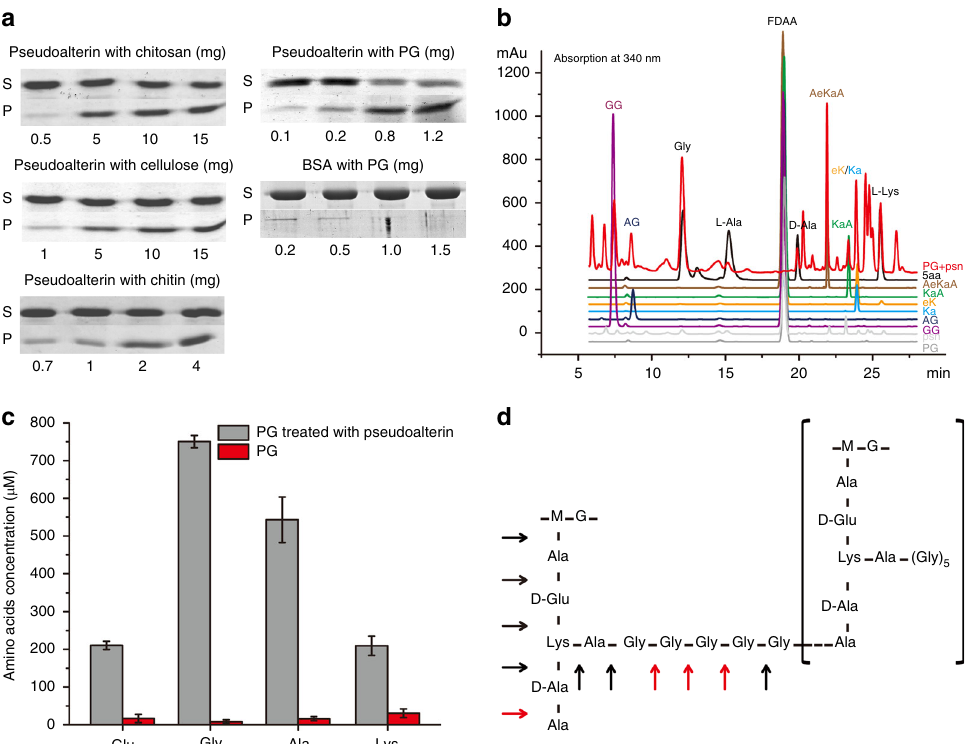
Fig. 5 PG binding and degradation by pseudoalterin. a SDS-PAGE analysis of the binding ability of pseudoalterin on three insoluble polysaccharides and PG. The experiments were performed with a fi xed amount of pseudoalterin (0.2 mg ml − 1 ) and increasing concentrations of substrates. “ S ” and “ P ” refer to the amount of protein present in the supernatant and the pellet after centrifugation, respectively. BSA in place of pseudoalterin was used as a negative control. Each graph is a representative of at least three repeats. b Chiral derivatization-HPLC analysis of the D / L -amino acids and the peptides released from PG of strain MCCC0423 by pseudoalterin hydrolysis. 5aa is a mixture of fi ve standard amino acids (Gly, D / L -Ala, D -Glu and L -Lys). c Analysis of the amino acids released from PG of strain MCCC0423 by pseudoalterin hydrolysis with an Automatic Amino Acid Analyzer (Hitachi L8900, Japan). Data are from triplicate experiments (mean ± SD). d The cleavage sites of pseudoalterin on strain MCCC0423 PG. Arrows indicate the cleavage sites determined according to analysis of the products released by pseudoalterin from two synthetic PG peptides, AaKAGGGGGA and Lactic acid-AeKAGG. Red and black arrows indicate the preferred and less preferred bonds by pseudoalterin, respectively, which are deduced based on the relative production of the released products in MS spectra (Supplementary Figs. 4 and 5). M, NAM; G, NAG. Source data are provided as a Source Data fi